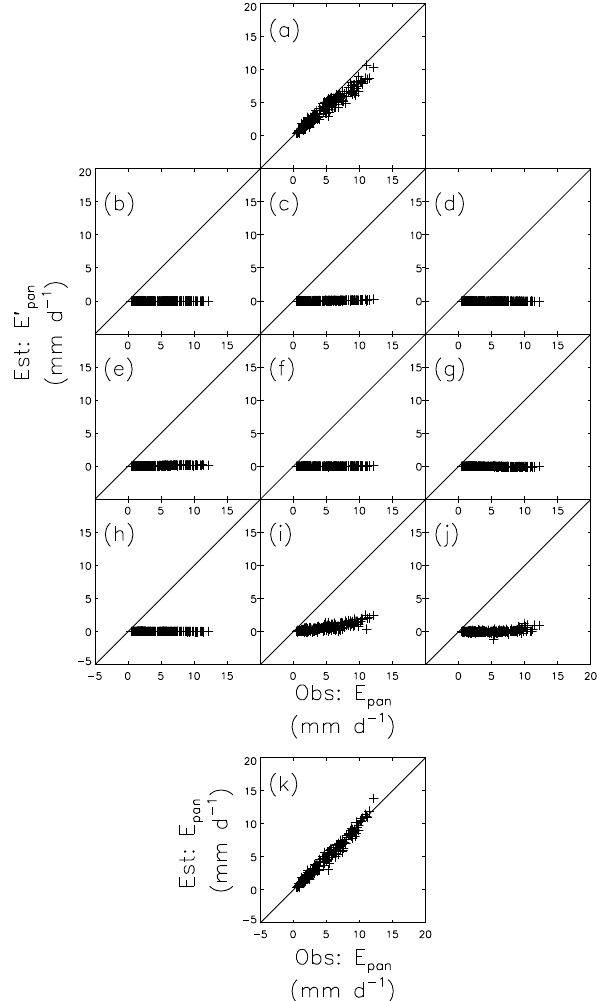
Fig. 2. Estimated E pan (Eq. 8; prime symbol (’) denotes par- tial results) versus observed E pan for 237 days (1:1